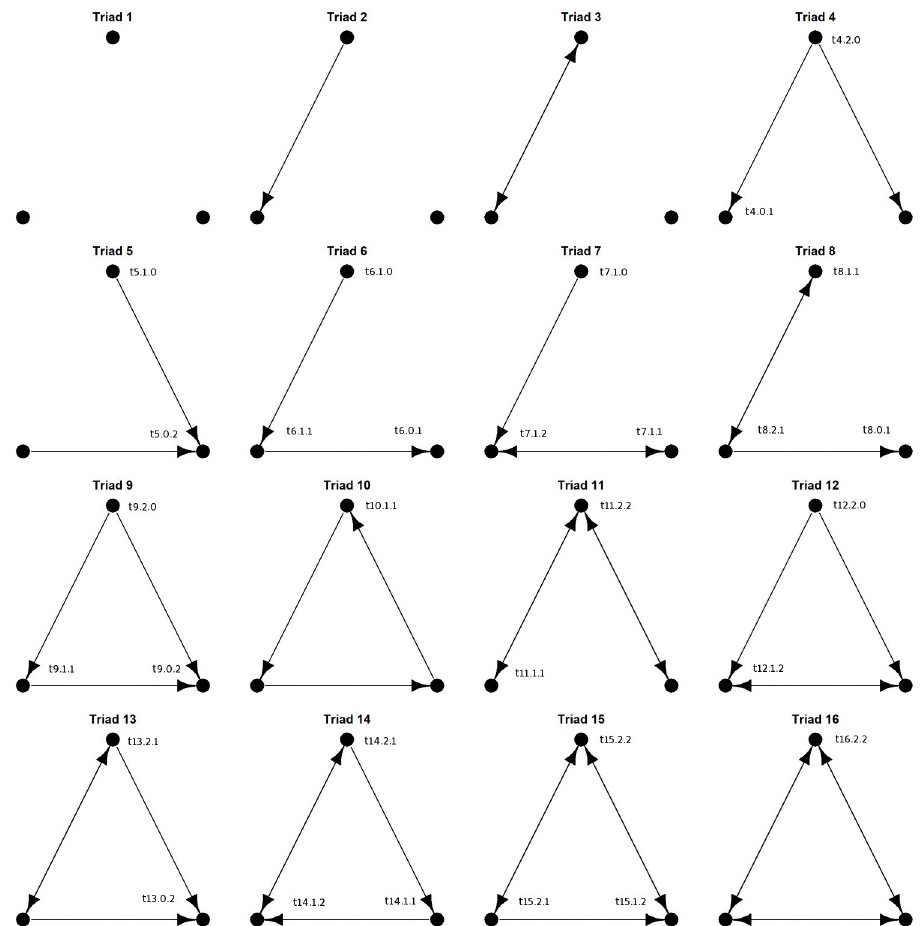
Fig 2. Structures of sixteen possible triads of directed interactions. Unique node positions within each connected triad are indicated with the triad number, out-degrees, and in-degrees for that node (eg. node t4.2.0 is within triad 4, has 2 out-degrees, and 0